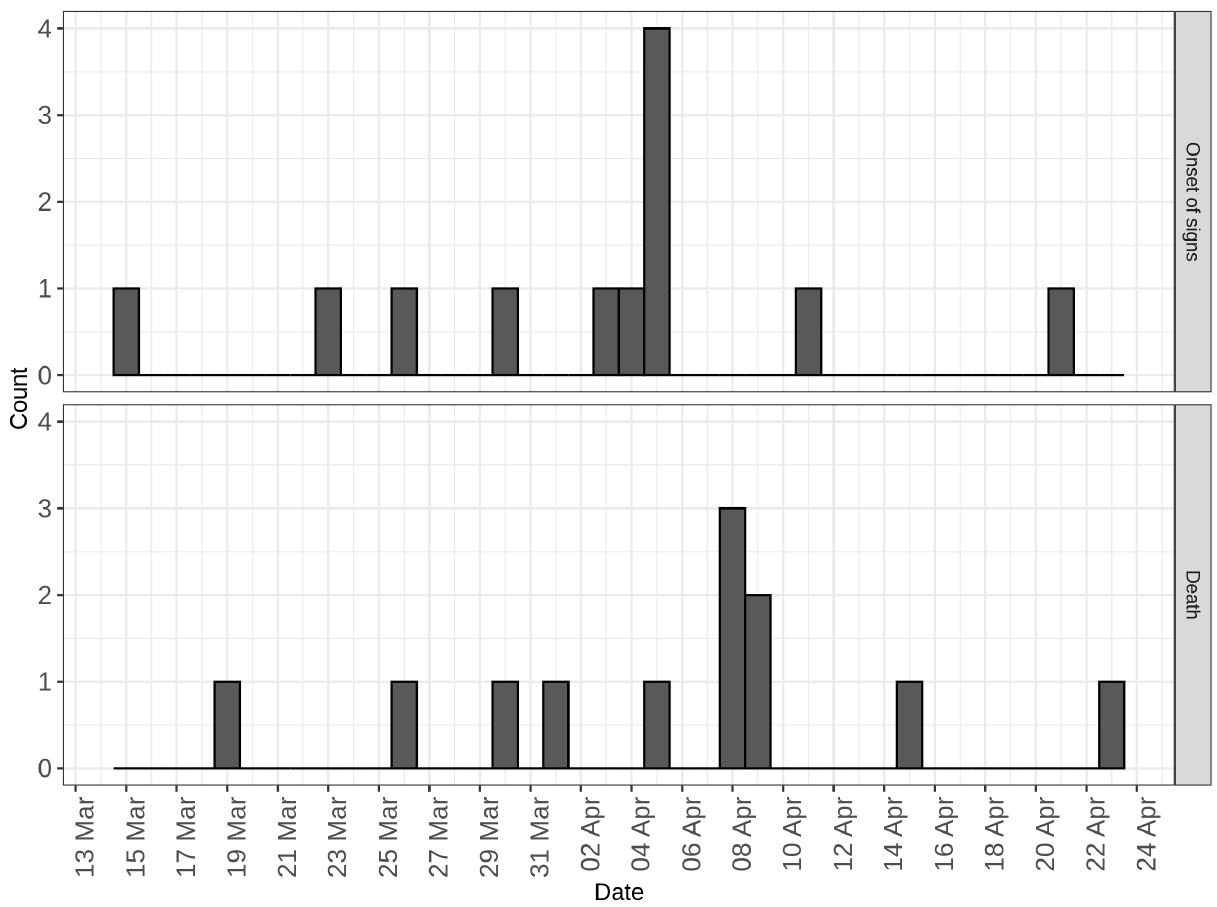
Figure 2. Frequency histogram showing counts of animals showing clinical signs and counts of